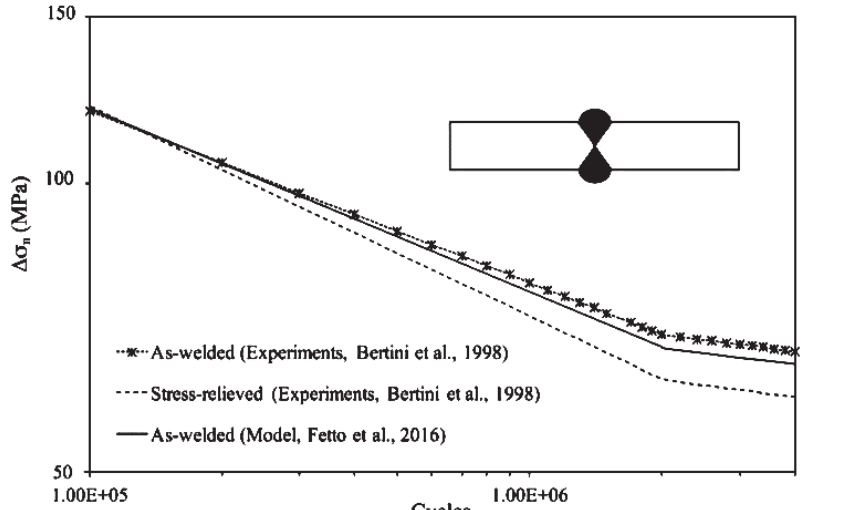
Figure 5: Residual stress influence on fatigue strength of the AA 6063 butt-welded joint predicted by Eq. (7).